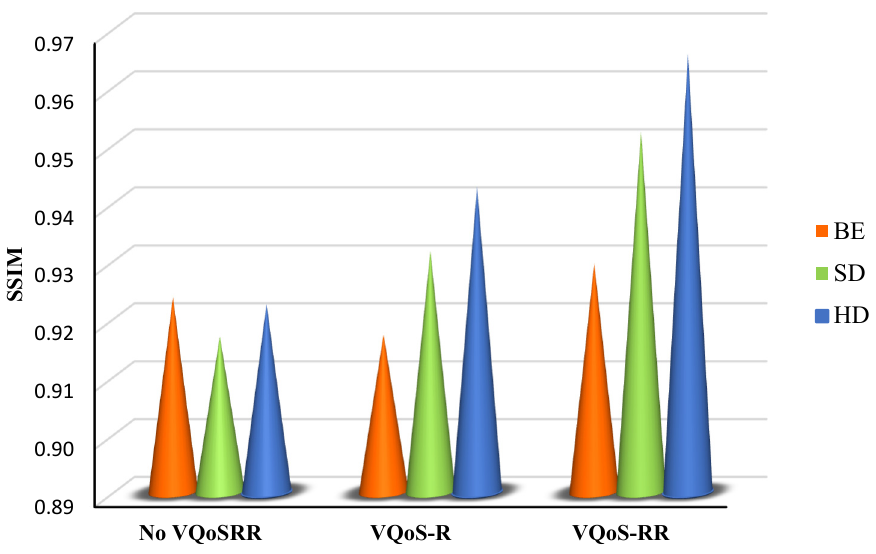
Figure 11. The mean SSIM value of the tested videos. Below are the results obtained from the subjective QoE tests, where Figures 12 and 13 represent the MOS scores rated by users of 15 test conditions for each test case; these measurements were based on MOS scores (1–5).